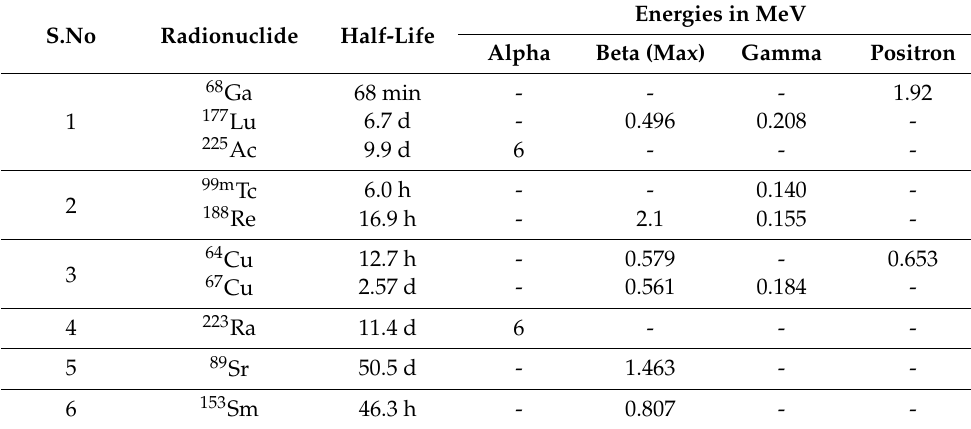
Table 1. Half-life and energies of theragnostic duos and therapeutic